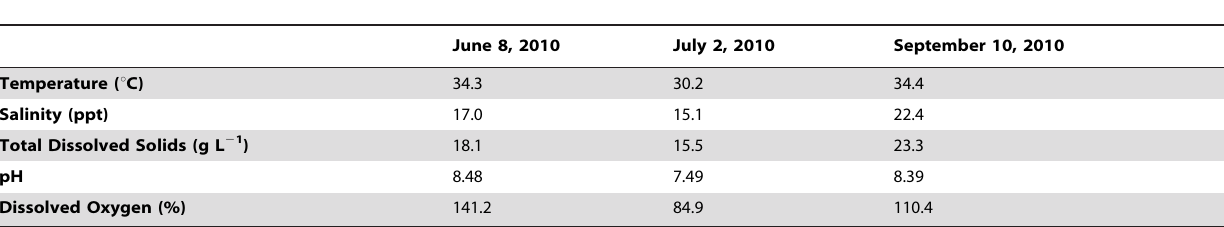
Table 1. Point Aux Pins salt marsh inlet water column physical and chemical